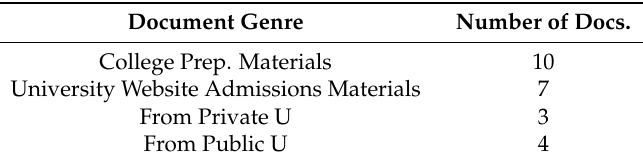
Table 1. Institutional documents used in the